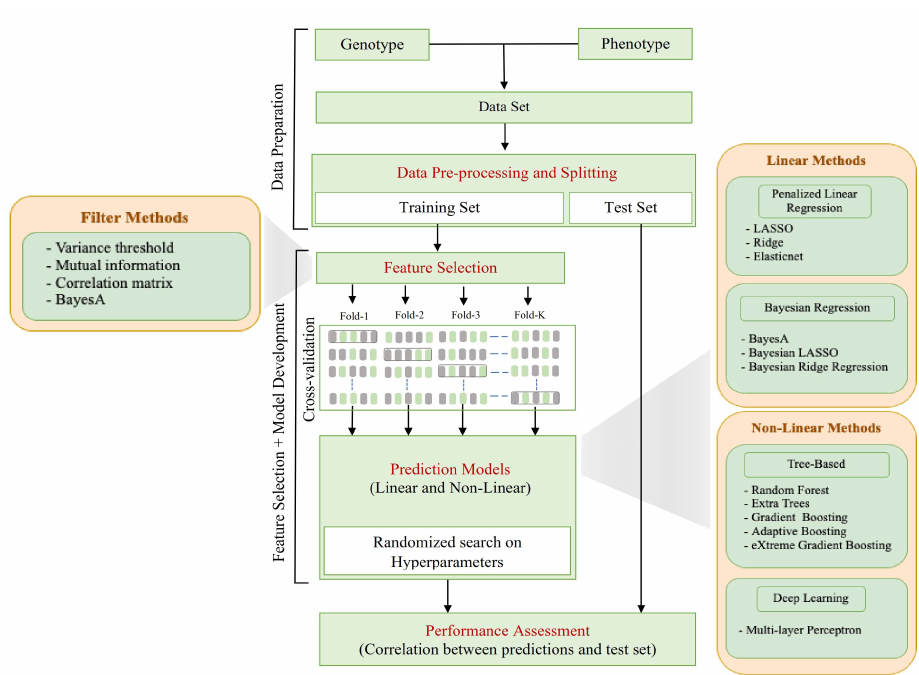
Figure 1. The wheat grain yield prediction scheme using SNP data and classification of the im- plemented methods. Four filter feature selection methods were implemented: variance threshold, correlation matrix, mutual information, and BayesA. The predictive methods are categorized into linear and non-linear and belong to four different computational families. Performance was assessed using Pearson’s correlation. The four main steps of the GP workflow are highlighted in